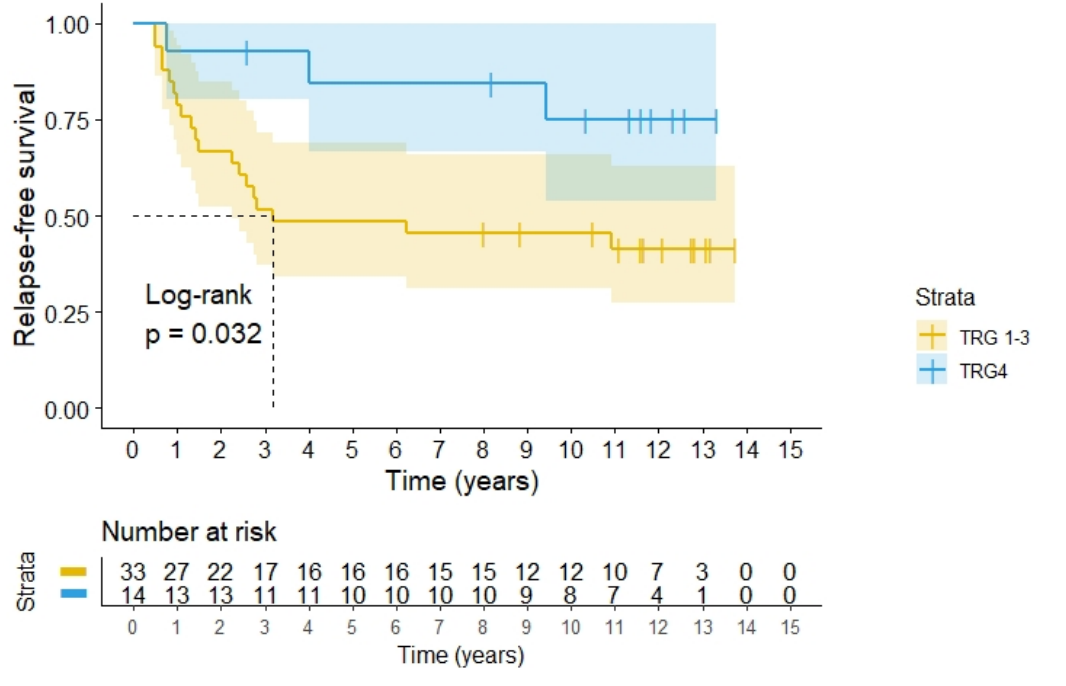
Figure 4. RFS according to histopathology classification according to Dworak’s TRG grades for 47 patients operated for rectal adenocarcinomas after preoperative radiochemotherapy with hyperthermia. TRG4 means pCR.